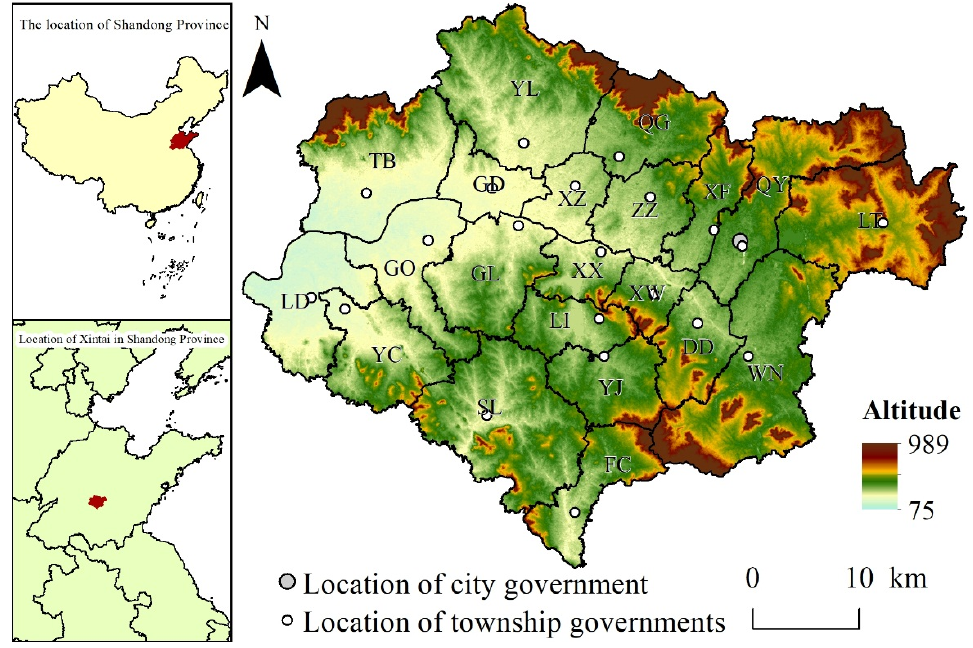
Figure 2. Location and topography of Xintai